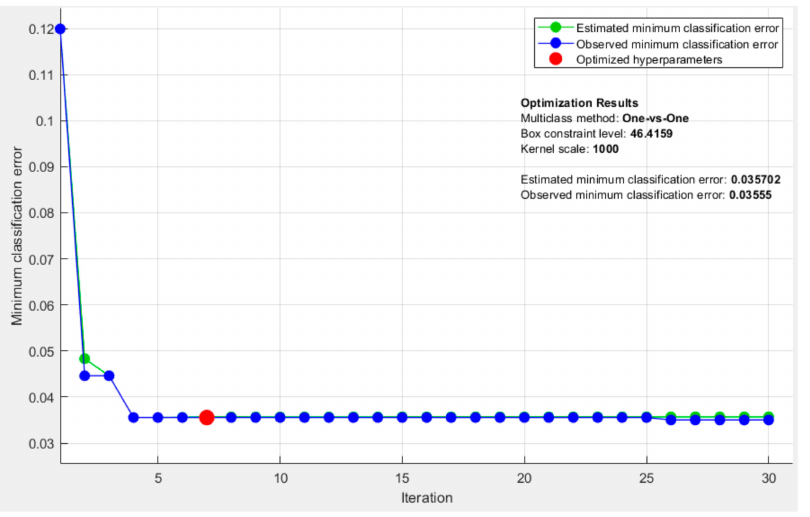
Figure 11. Minimization of classification error plot generated during the training phase of SVC using the Grid search